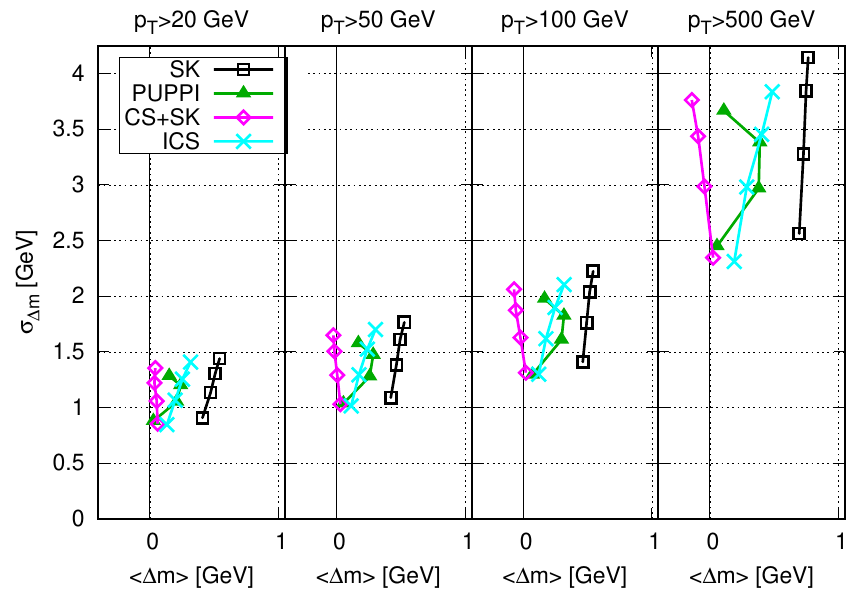
Figure 10. Comparison of the jet mass resolution as a function of jet mass bias for four methods: SoftKiller, PUPPI, CS+SoftKiller and ICS. Dijet events are used with di(cid:11)erent jet p T cut in each panel. Each curve corresponds to a di(cid:11)erent method and the 4 points on each curve correspond to N PU = 30, 60, 100 and 140 from bottom to